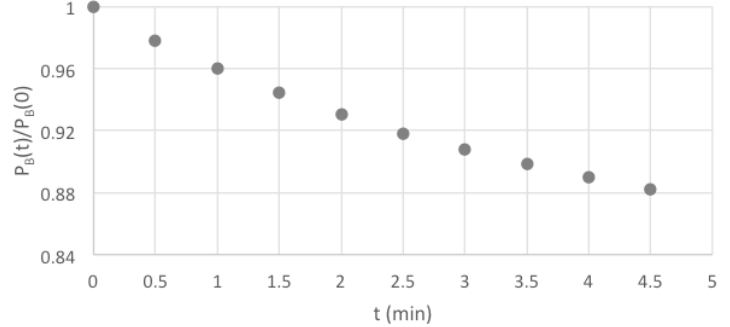
Figure 8. The decrease in fluorescence intensity of a DPA solution with time after turning on the UV lamps continuously.